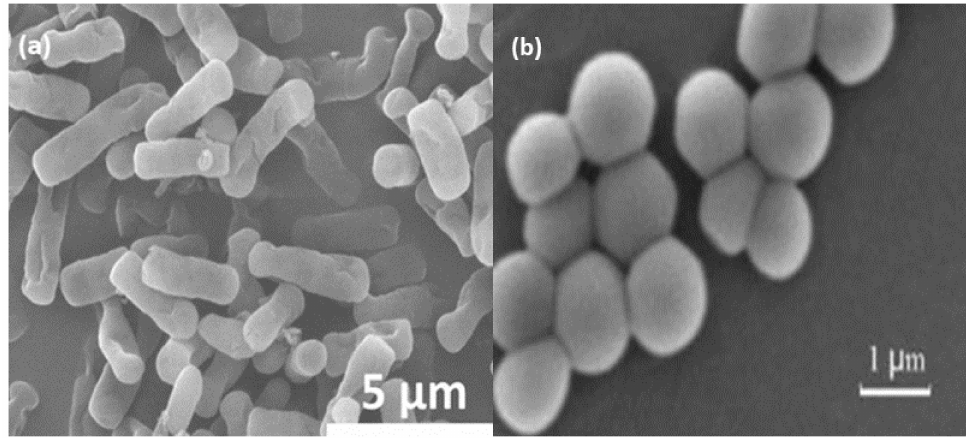
Figure 5. The morphological structure of ( a ) E. coli and ( b ) S. aureus [82].